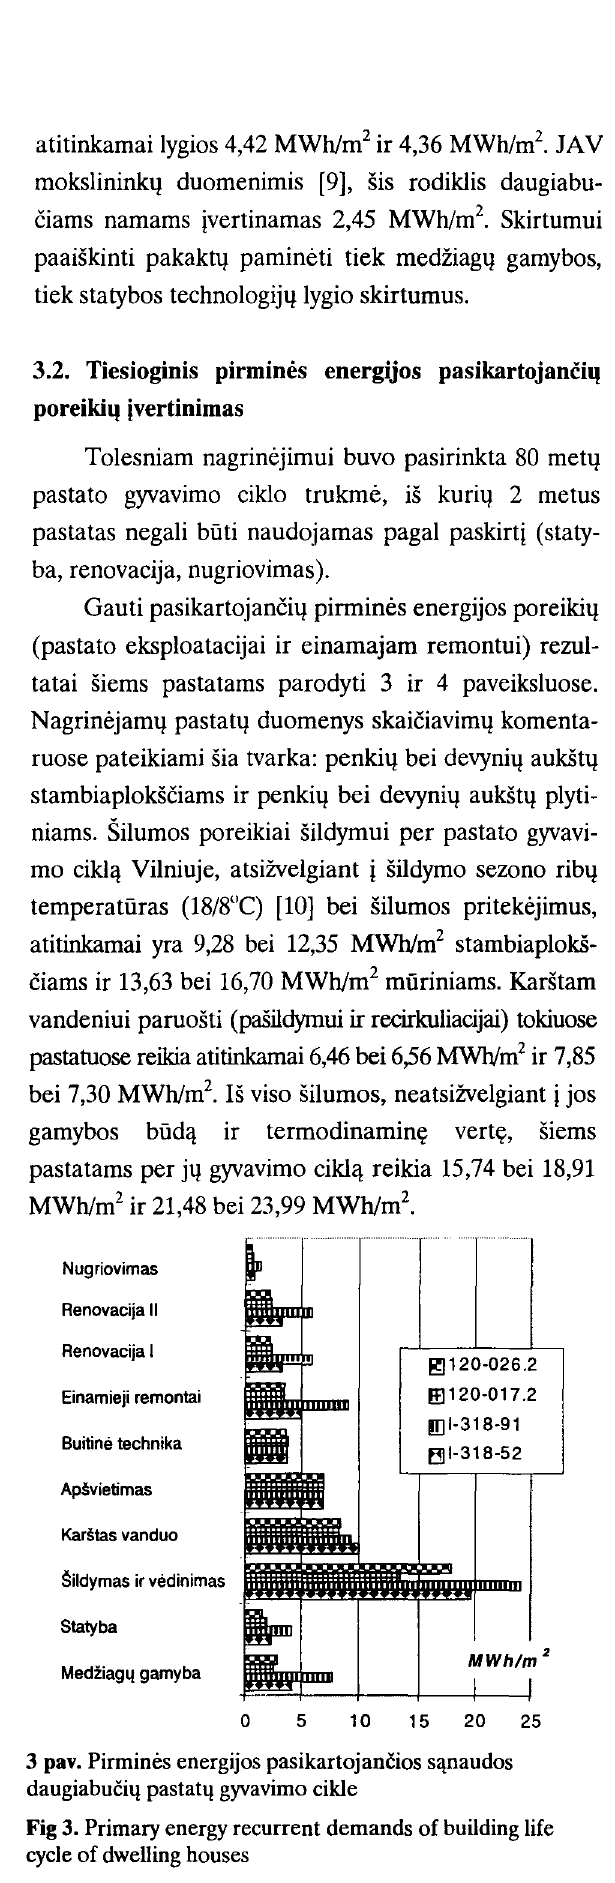
Fig 3. Primary energy recurrent demands of building life cycle of dwelling houses